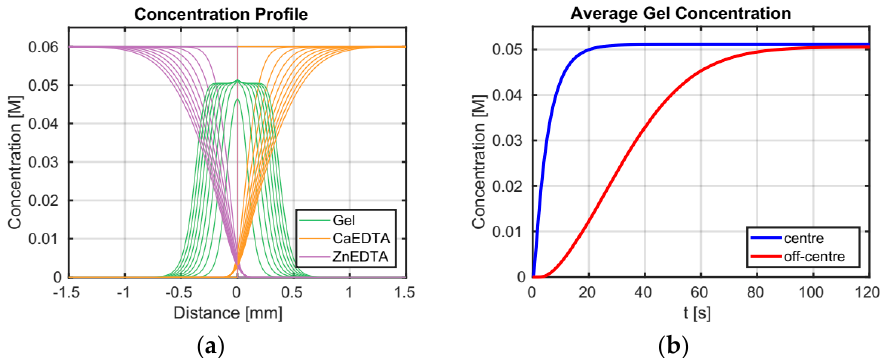
Figure 10. ( a ) Calculated concentration profiles for CLEX components and alginate gel at the contact zone plotted every 12 s for the first 120 s of the gel formation process. ( b ) Evolution of gel concentration at the junction of the two CLEX solutions (region of interest is 50 µm across) and at an off-centre position (offset of 200 µm) to illustrate the difference in the gel formation kinetics due to diffusion of the cross-linking ions at these two locations. The gel concentration is expressed in terms of moles of monomer per litre. Observed concentration profiles are in qualitative agreement with SAXS data obtained at pH 7, where the used model correctly describes the exchange reaction whereby the exchange reaction in complete. At higher pH not all calcium supplied as CaEDTA is released and made available for gel formation.